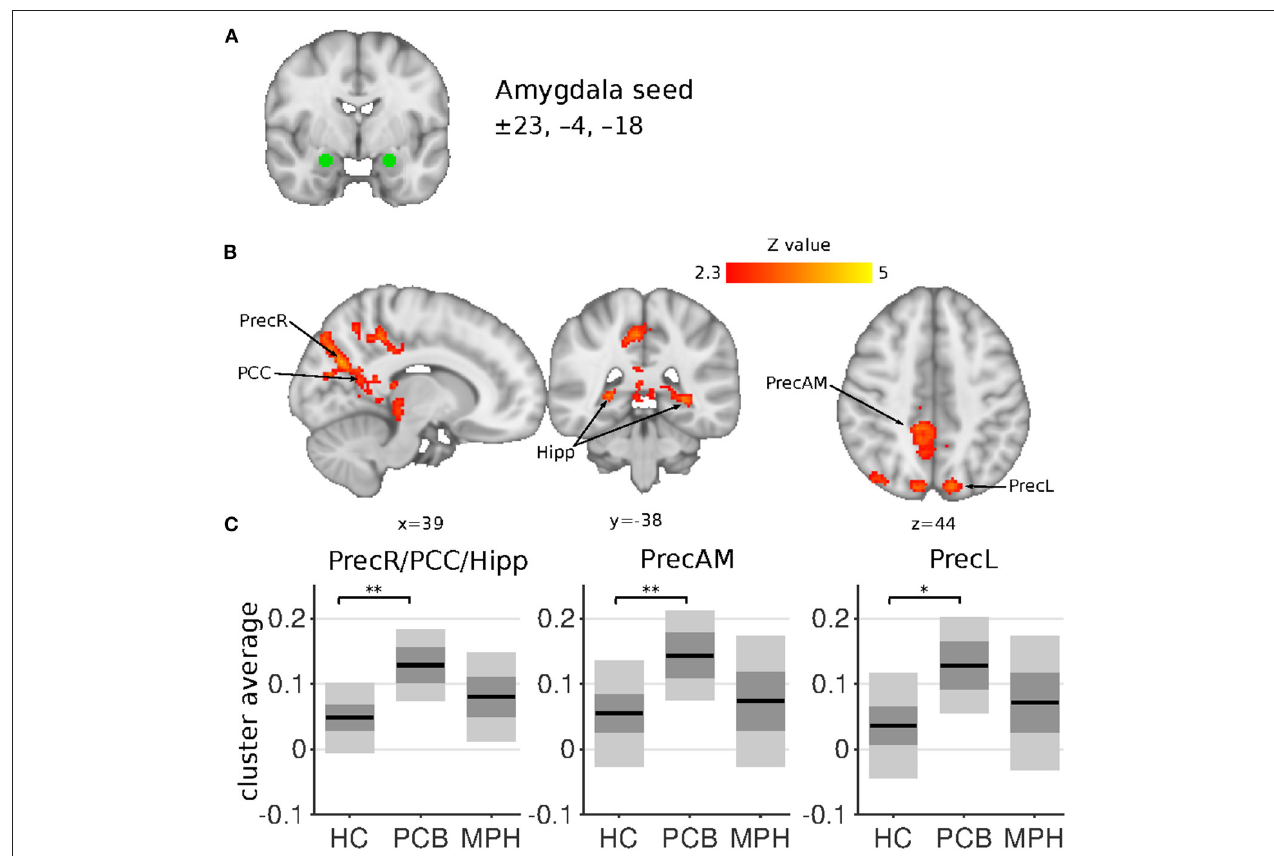
FIGURE 2 | Amygdala connectivity differences between HC, DBD-PCB, and DBD-MPH groups. (A) Location of the amygdala seed. (B) Clusters showing significant connectivity differences ( Z > 2.3, cluster p < 0.05). (C) Average Fisher- Z transformed amygdala connectivity in the significant clusters. Dark gray patches represent the 95% confidence interval and light gray patches represent the standard deviations. Lines represent the group means. All shown coordinates are in MNI space. PrecR, right posterior precuneus; PCC, posterior cingulate cortex; Hipp, hippocampus; PrecAM, medial anterior precuneus; PrecL, left posterior precuneus; HC, healthy control; PCB, placebo; MPH, methylphenidate; *cluster- p < 0.05; **cluster p <